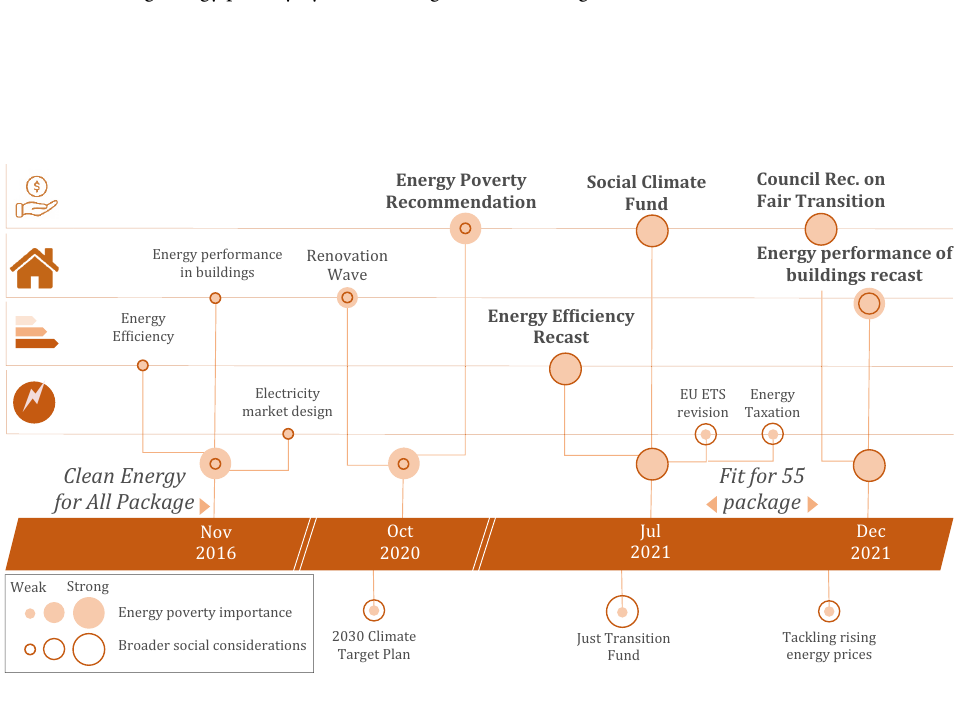
Figure 1. Timeline of recent EU climate and energy policy initiatives and their focus on energy poverty and social aspects. For an explanation of symbol scaling, see